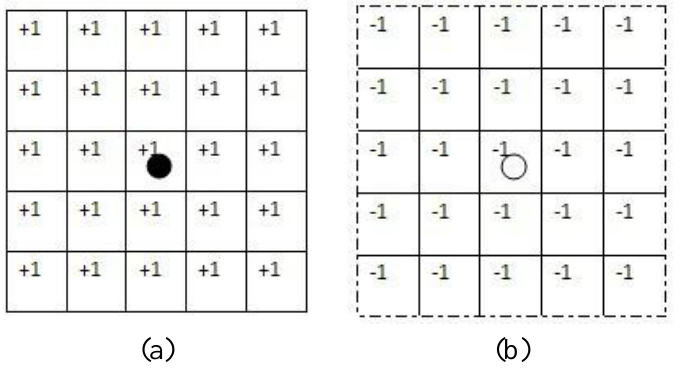
Figure 4. the ROC of sensor nodes ( a ) alarmed nodes ( b ) non-alarmed